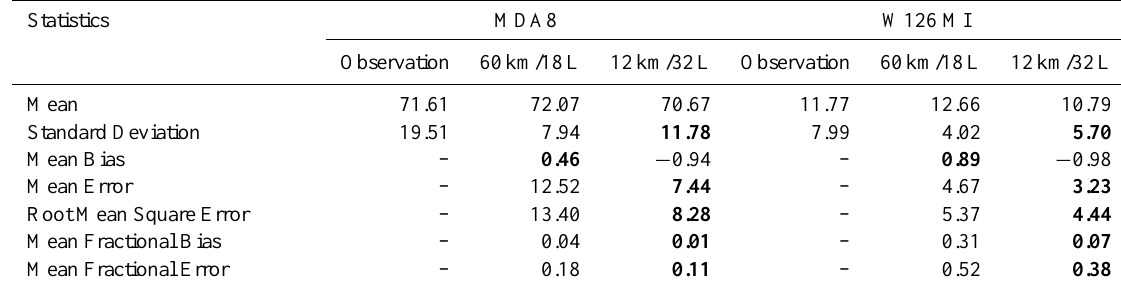
Table 4b. Same as Table 4a but for CASTNET sites, and model results were extracted at identical site altitudes a , b . Statistics MDA8 W126 MI Observation 60km/18L 12km/32L Observation Mean Standard